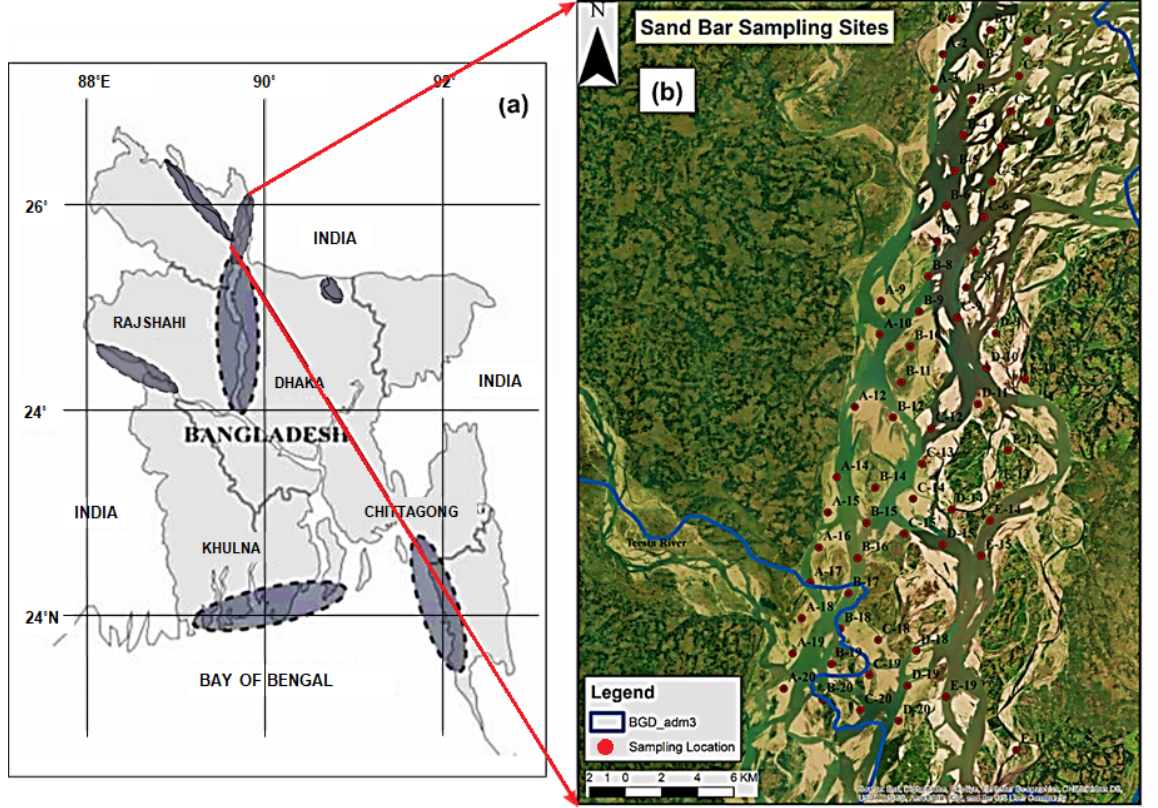
Figure 1. Location maps showing ( a ) the distribution of significant concentrations of heavy mineral sands in Bangladesh and, ( b ) sand bar sampling sites (red dots) along a 40 km stretch of the northern Brahmaputra River, Kurigram District (blue line shows the Kurigram District border).